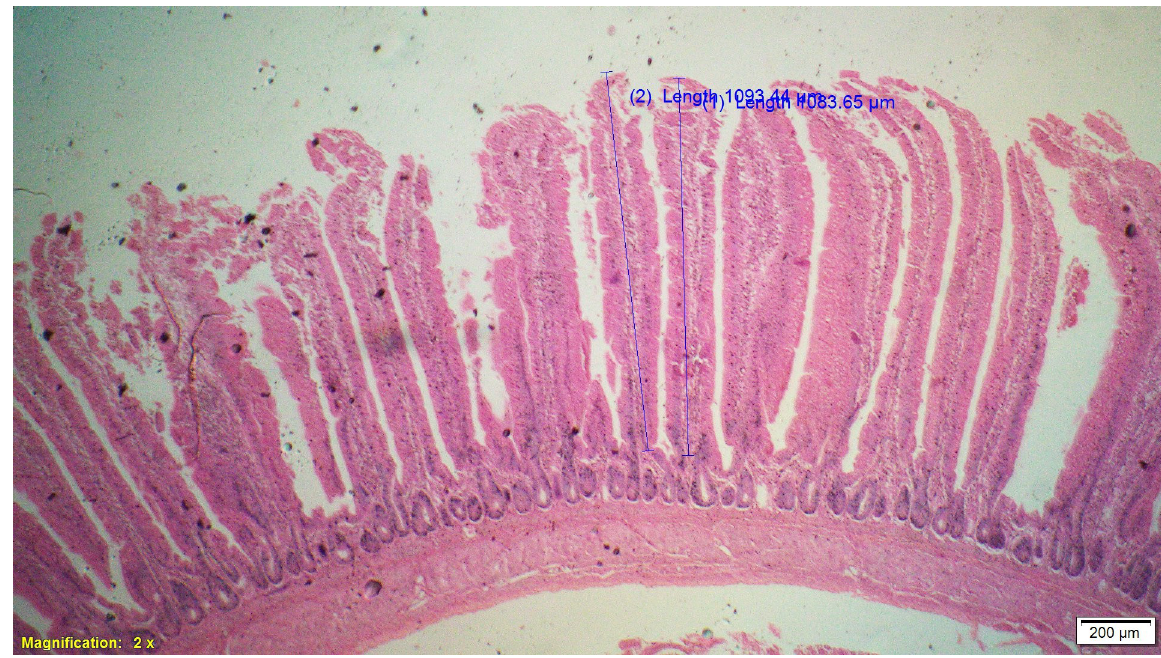
Fig 6. Photomicrograph of the cross section of Jejunum from probiotic + chicory + coriander group (T6), H&E, 2x.